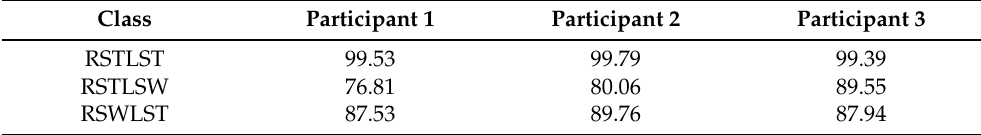
Table 3. Precision percentage of the labeling system for each class and